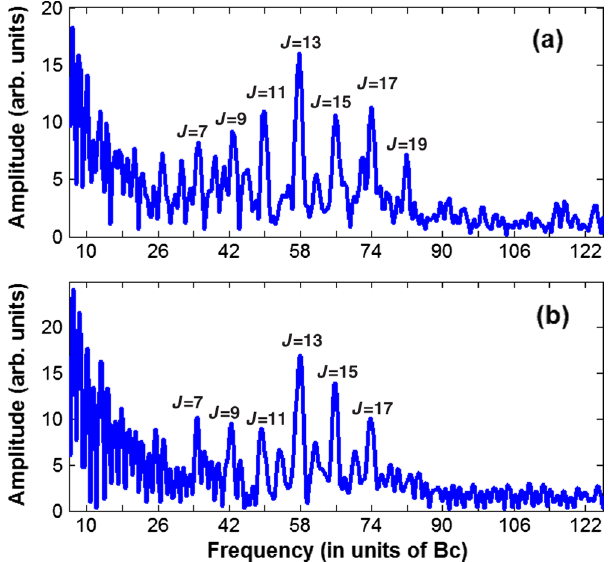
FIG. 3. The Fourier-transform spectra of the oscillation curves in Fig. 2(a) for the parallel (a) and perpendicular (b) cases. The numbers indicate the beat